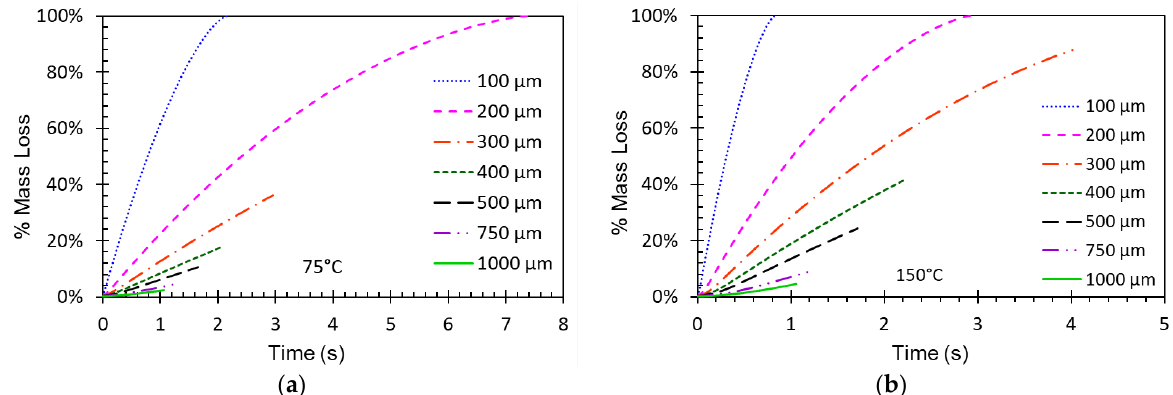
Figure 10. The mass loss of droplets with different initial diameters; ( a ) condition 1 (75 °C); ( b ) condition 2 (150 °C).